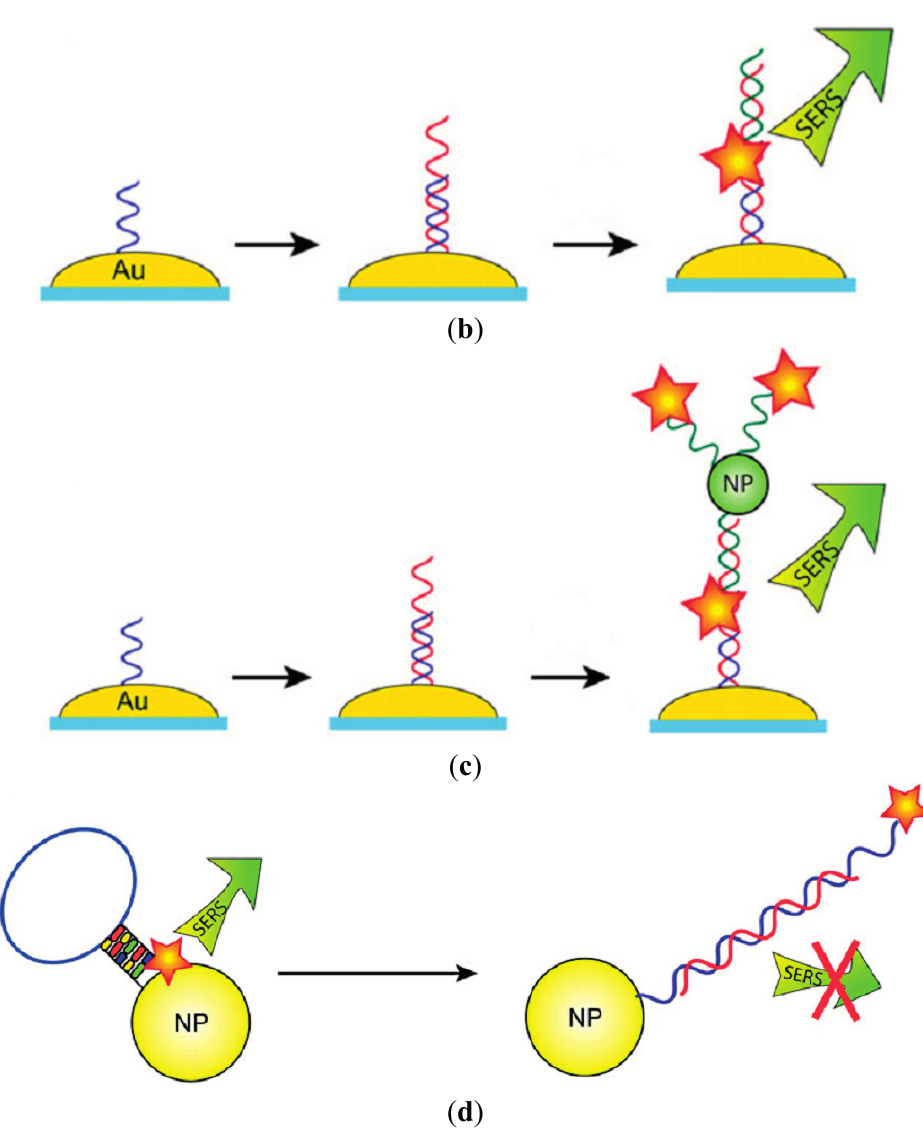
Figure 6. Different detection schemes using SERS. ( a ) DNA hybridization recognition by Raman tag; ( b ) direct recognition by Raman tag using nanoparticle array substrate for sandwich assay; ( c ) enhanced sensitivity by using secondary nanoparticle for sandwich assay; and ( d ) Molecular beacon for detection of a reduction in SERS